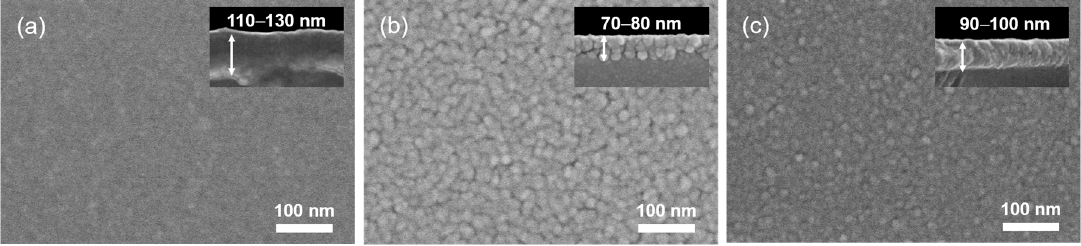
Figure 3. FE-SEM surface images of the ( a ) Ga oxide; ( b ) Sn oxide; and ( c ) Ga:Sn oxide films. The insets show the cross-sectional FE-SEM images of the films.